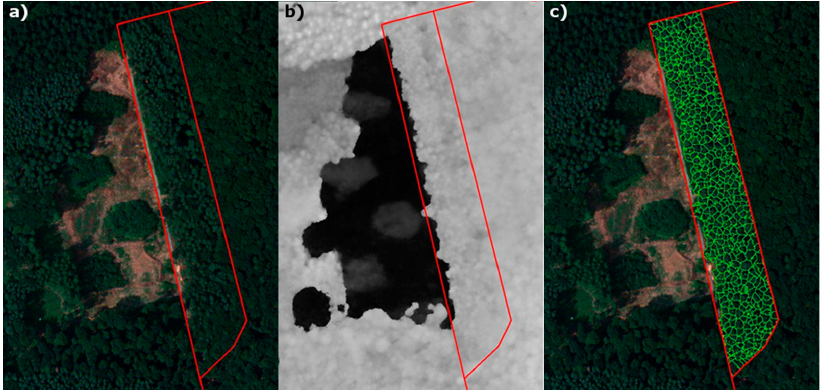
Figure 2. Segmentation in the case of ROI SO 100 (Figure 1). ( a ) Orthophotomap—a RGB composition in natural colors, ( b ) An elevation model acquired as a result of the matching of images, ( c ) The particular tree crowns were determined using segmentation based on the watershed algorithm.